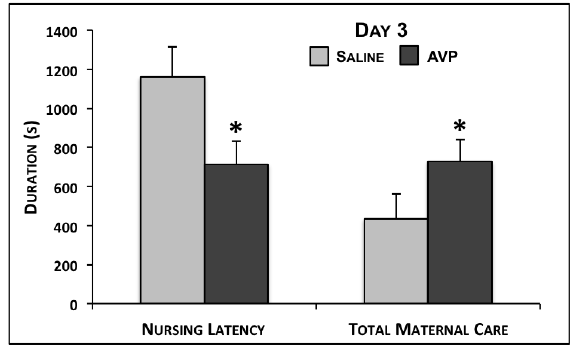
Figure 2. Mean + SEM duration values for nursing latency and total maternal care (sum of pup grooming and nursing) on day 3 of lactation during a 30 min maternal aggression observation test of chronic social stressed dams treated with either saline or AVP.